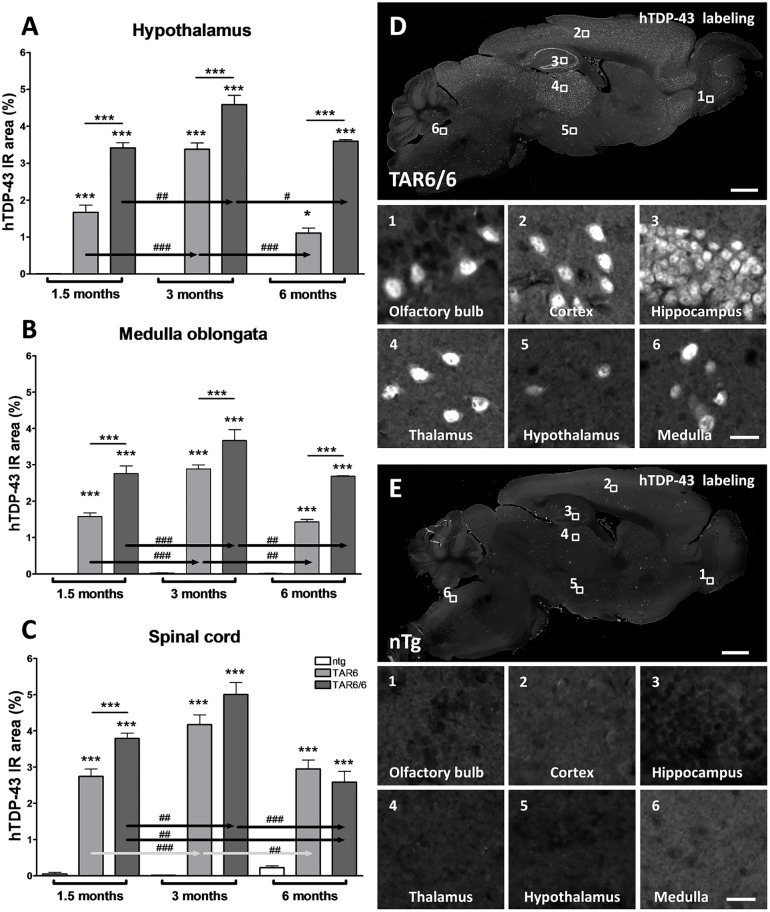
Quantification of hTDP-43 expression in ntg, TAR6 and TAR6/6 mice.Quantitative hTDP-43 expression in hypothalamus (A), medulla oblongata (B) and spinal cord (C) analyzed by immunofluorescent labeling of CNS samples. (D, E) Representative overview image and magnifications of hTDP-43 labeling of a brain section (olfactory bulb (1), cortex (2), hippocampus (3), thalamus (4), hypothalamus (5) and medulla oblongata (6)) of 3 months old TAR6/6 (D) and ntg (E) mice. Scale bars: Overview images = 1000 μm; magnification images = 20 μm. (A, B) 1.5 months: ntg: n = 4; TAR6: n = 10; TAR6/6: n = 5; 3 months: ntg: n = 5; TAR6: n = 8; TAR6/6: n = 5; 6 months: ntg: n = 3; TAR6: n = 3; TAR6/6: n = 3. (C) n as in A, B exempt: 1.5 months: ntg: n = 3; TAR6: n = 11. (A-C) Two-way ANOVA followed by Bonferroni‘s post-hoc test. Mean+SEM. *significances between genotypes, #significances between age groups. *p<0.05, **p<0.01, ***p<0.001.